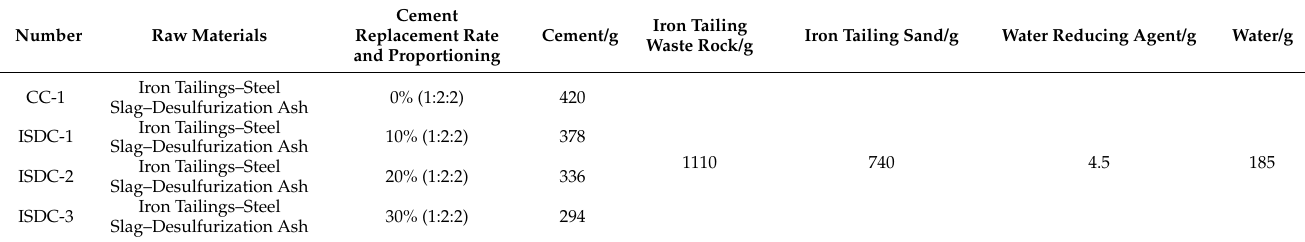
Table 4. Experimental study on the effect of ISD admixture variation on